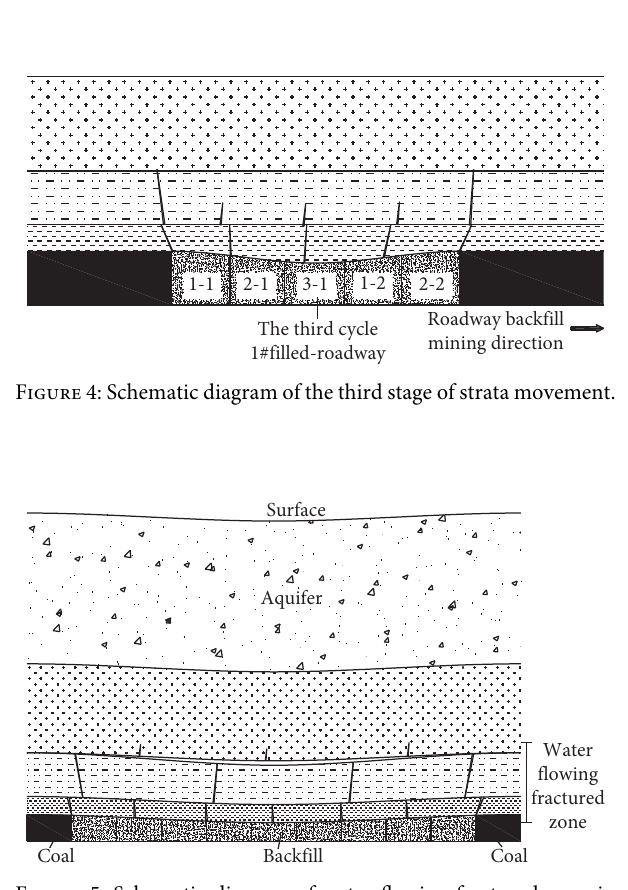
Figure 3: Schematic diagram of the second stage of strata movement.